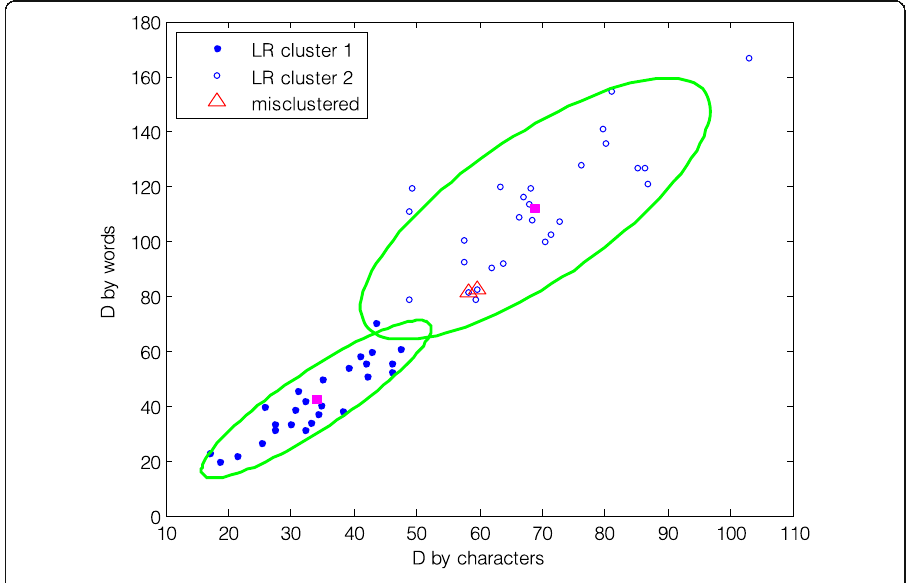
Fig. 1 Differentiation of L1 and L2 speakers using LR measure